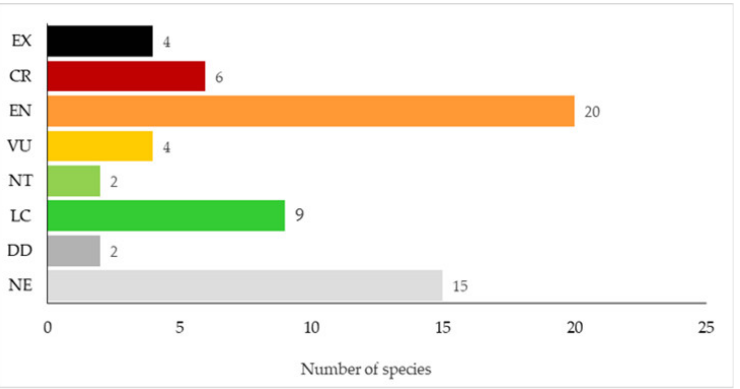
Figure 3. Number of species endemic to Turkish lakes listed in the categories of IUCN (2020) [26]. Among the considered species, four ( A. akili , A. nicaeensis , A.splendens , and P.